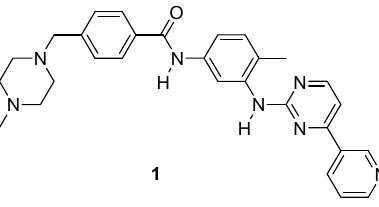
Figure 1. Structure of imatinib 1 .